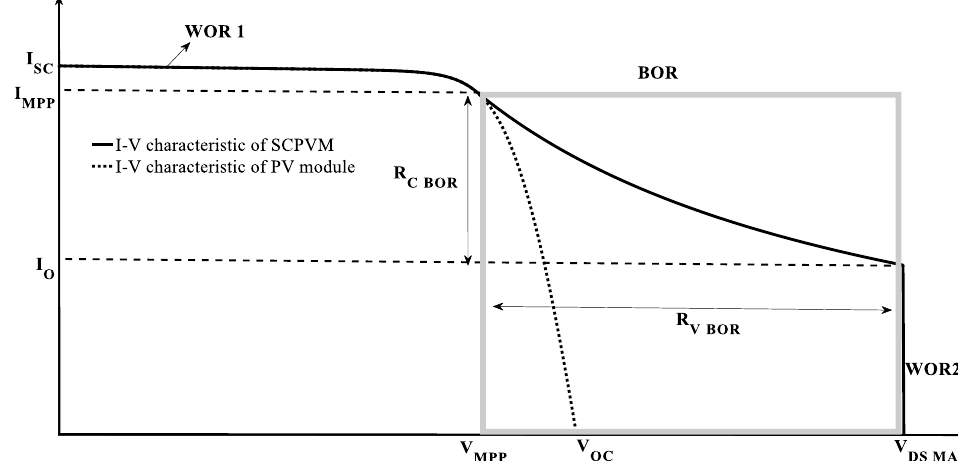
Figure 3. PV module current versus voltage (I-V) characteristic and boost-based self-controlled PV module (SCPVM) I-V characteristic.